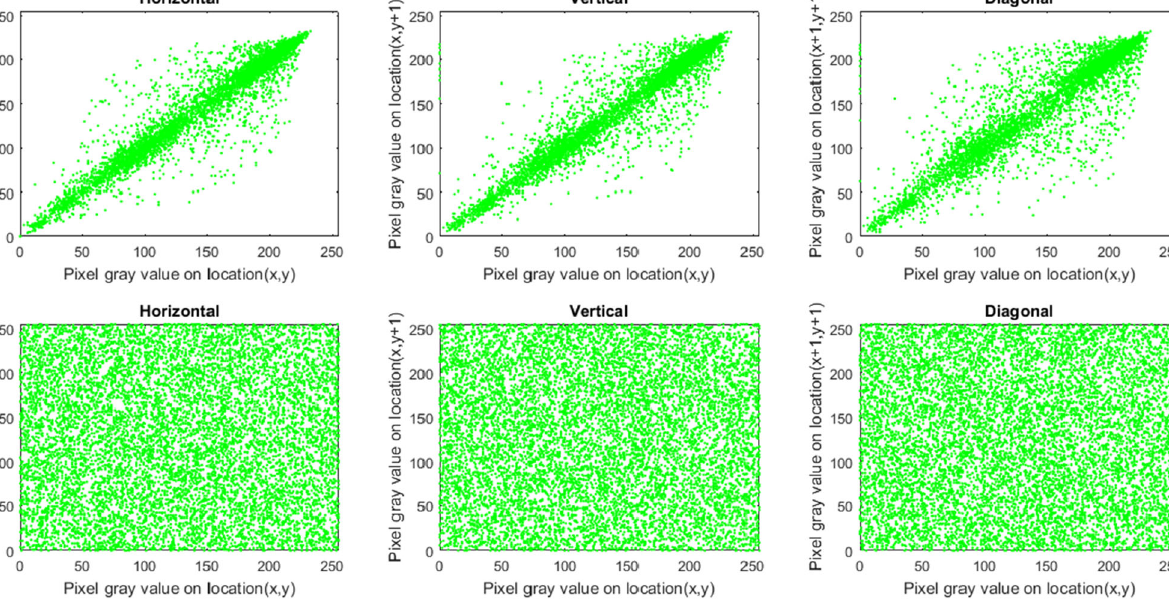
Fig. 5 Correlation distributions for green component of Og01 image, in where the top row represents the distributions for the green component of Og01 image, while the bottom row displays the distributions for the green component of Cg01